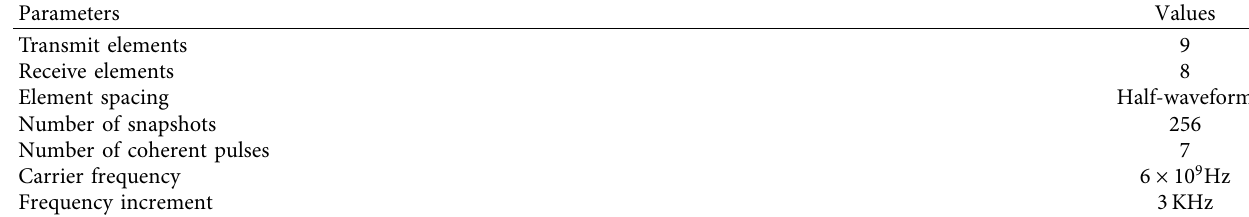
Table 1: The simulation parameters of the FDA-MIMO radar.